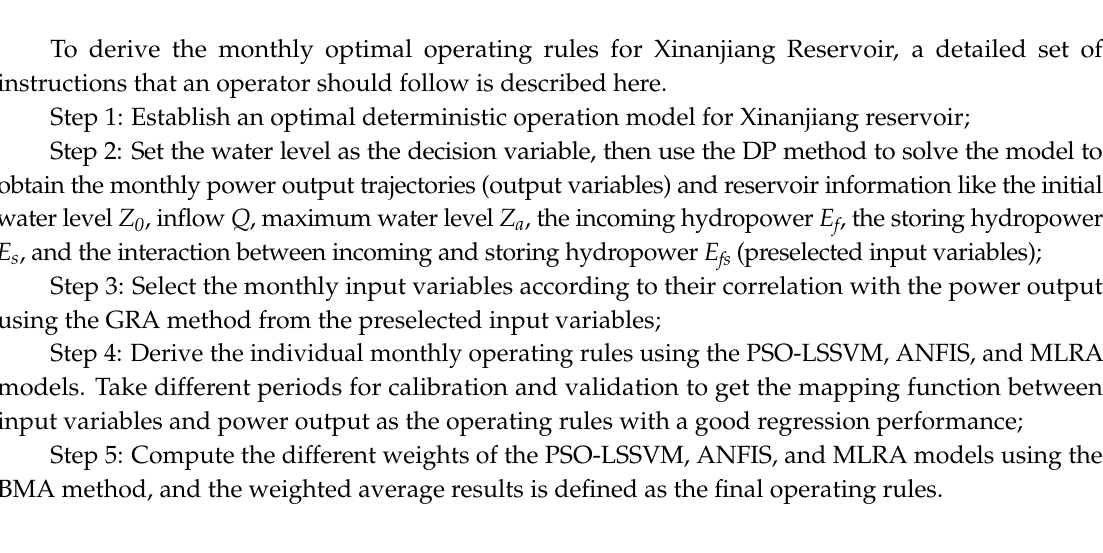
Figure 4. Conventional operating rules for hydropower generation of Xinanjiang Reservoir.